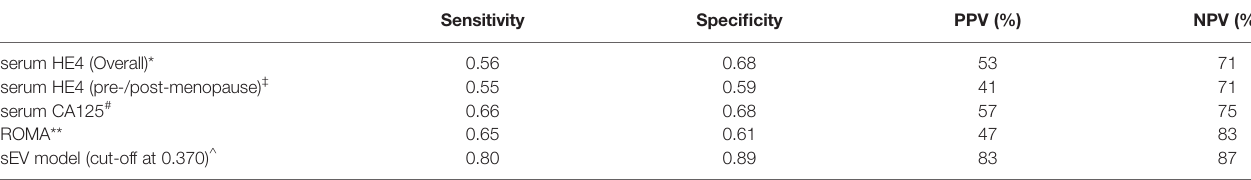
TABLE 3 | The sensitivity and speci fi city of serum markers and sEV model to identify the EOC patients from the whole cohort.